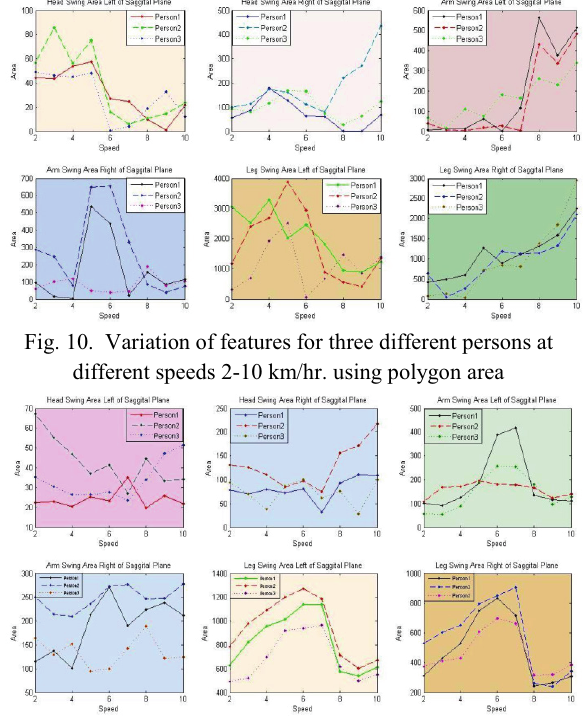
Fig. 11. Variation of features for three different persons at different speeds 2-10 km/hr. using convex hull